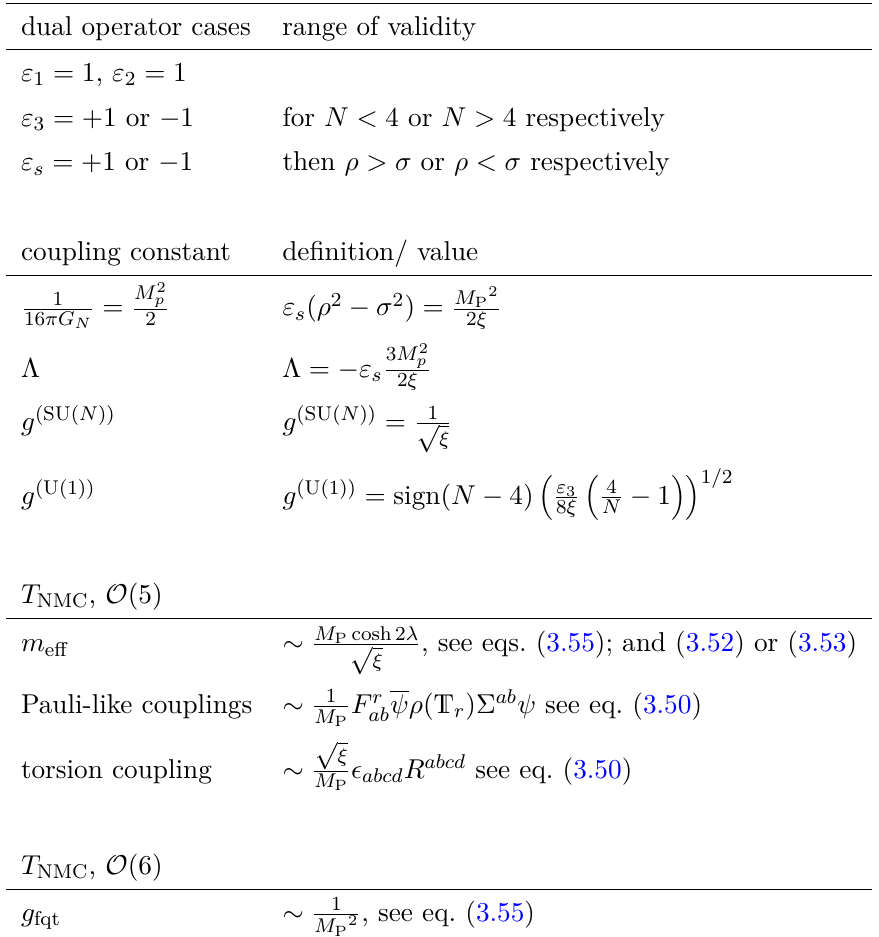
Table 2 . Upper panel: defining parameters of the dual operator, see eq. (2.36). Middle panel: gravity and gauge minimal couplings. Lower panel, dimension five operators: non minimal couplings present in the model. Parameters ξ and λ are phenomenological. The pauli-like gravitational coupling is proportional to the covariant derivative of the torsion 2-form, it vanish identically for a Riemannian connection. These terms may cancel exactly or not depending on the choice of ε ε 1 , ε 2 , ε 3 and ε ψ . The choice of such parameters also influences the susy conditions (2.41). Lower panel, dimension six operators: fermion quartic